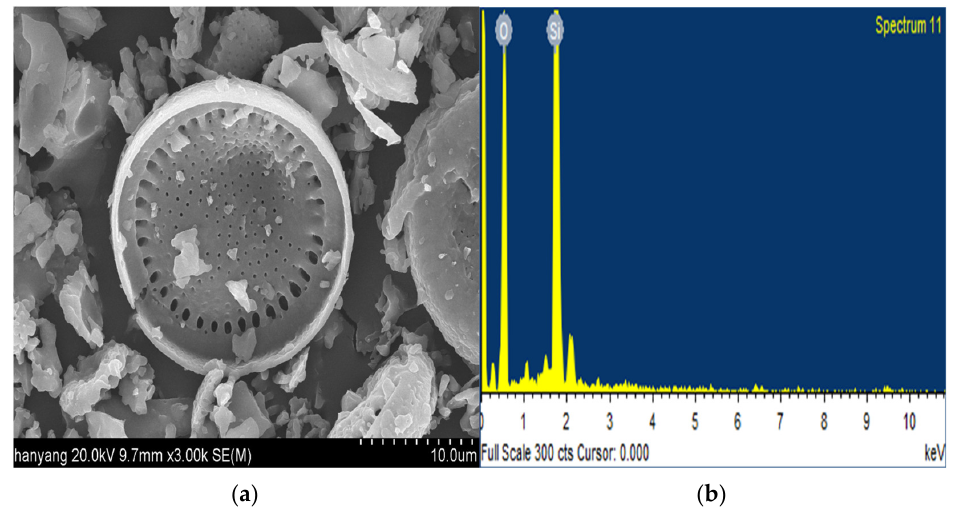
Figure 1. Scanning electron microscopy (SEM) images of diatomite at ( a ) ×3000 magnification; ( b ) EDX spectrum.